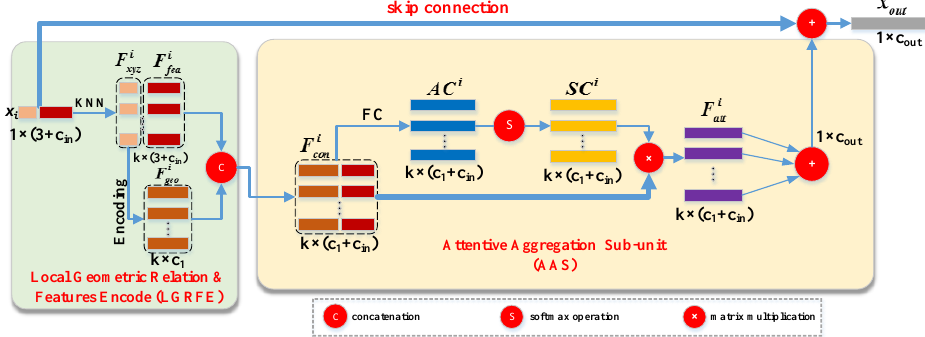
Figure 4. Local features aggregated cell.